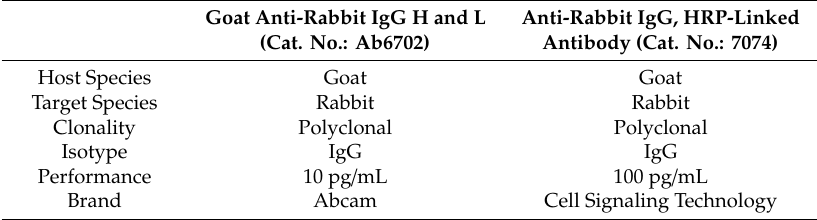
Table 1. Comparison between the two secondary antibodies used in our paper-based ELISA (P-ELISA) system for the detection of β -amyloid peptide 1–42 (A β